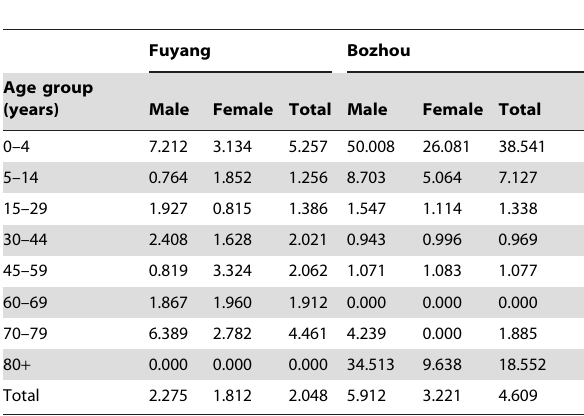
Table 3. Incidence rate of infectious diarrhea among age-sex groups in the flood-period (1/10 5 ).